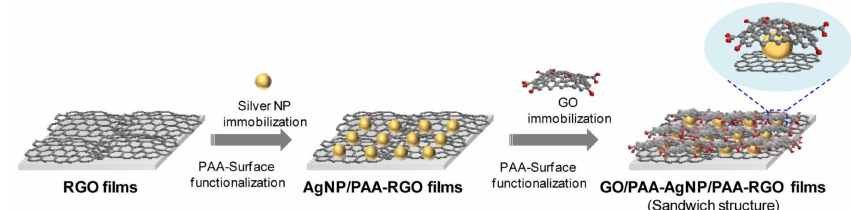
Figure 5. Fabrication Process of GO/PAA-AgNP/PAA-RGO films for application as SERS platform. Reproduced from [61] with permission; Copyright ACS 2012.